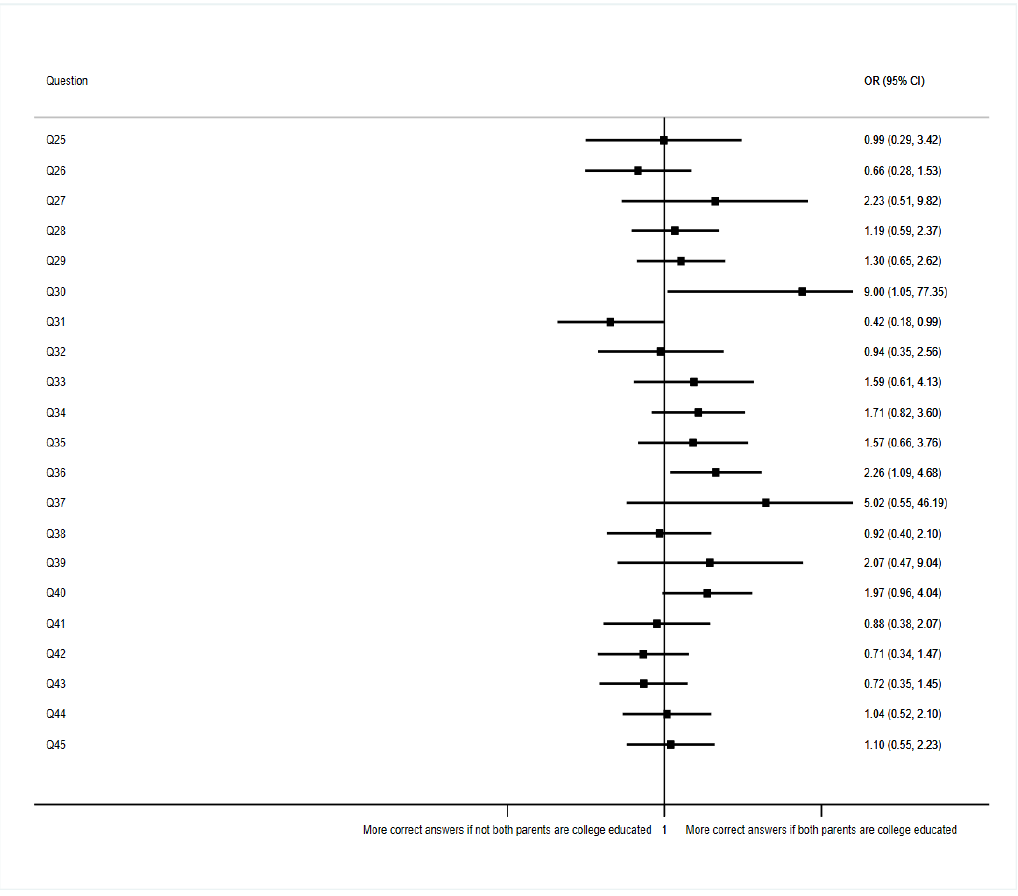
Figure 4. Association between questions regarding students’ opinions and parents’ educational background (ref Not both parents’ college -educated).